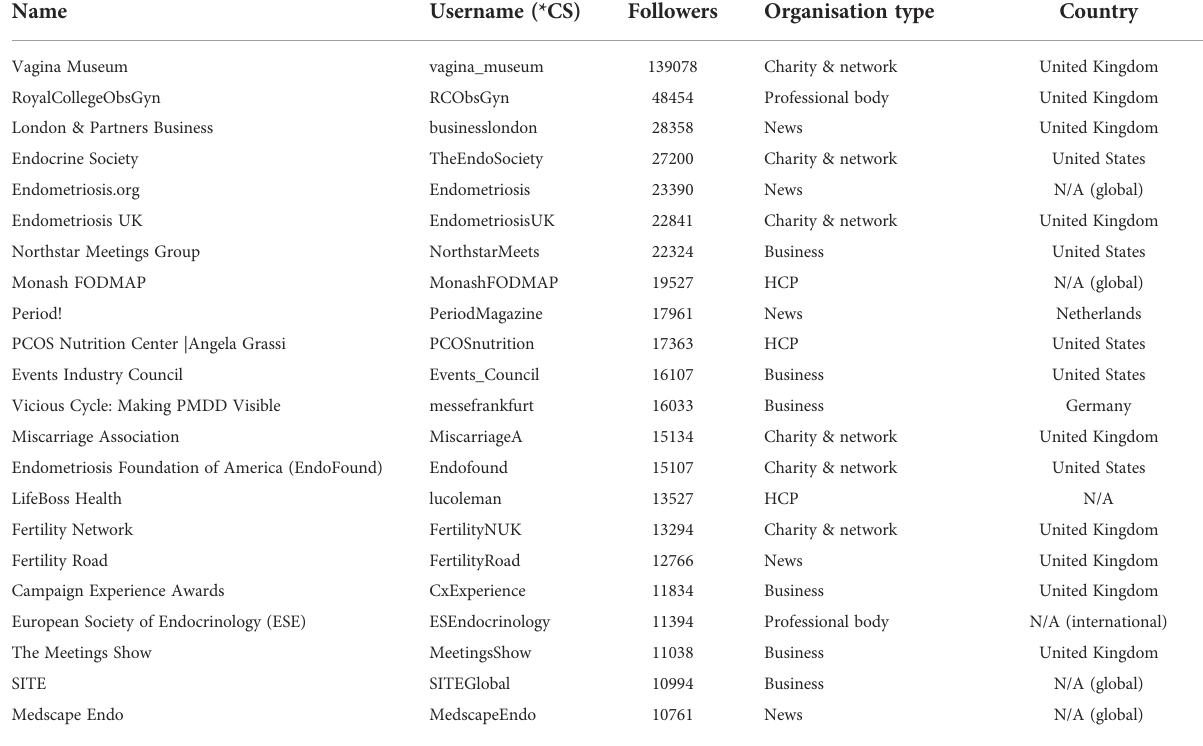
TABLE 2 Top 100 organisation in fl uencers for PCOS on social media